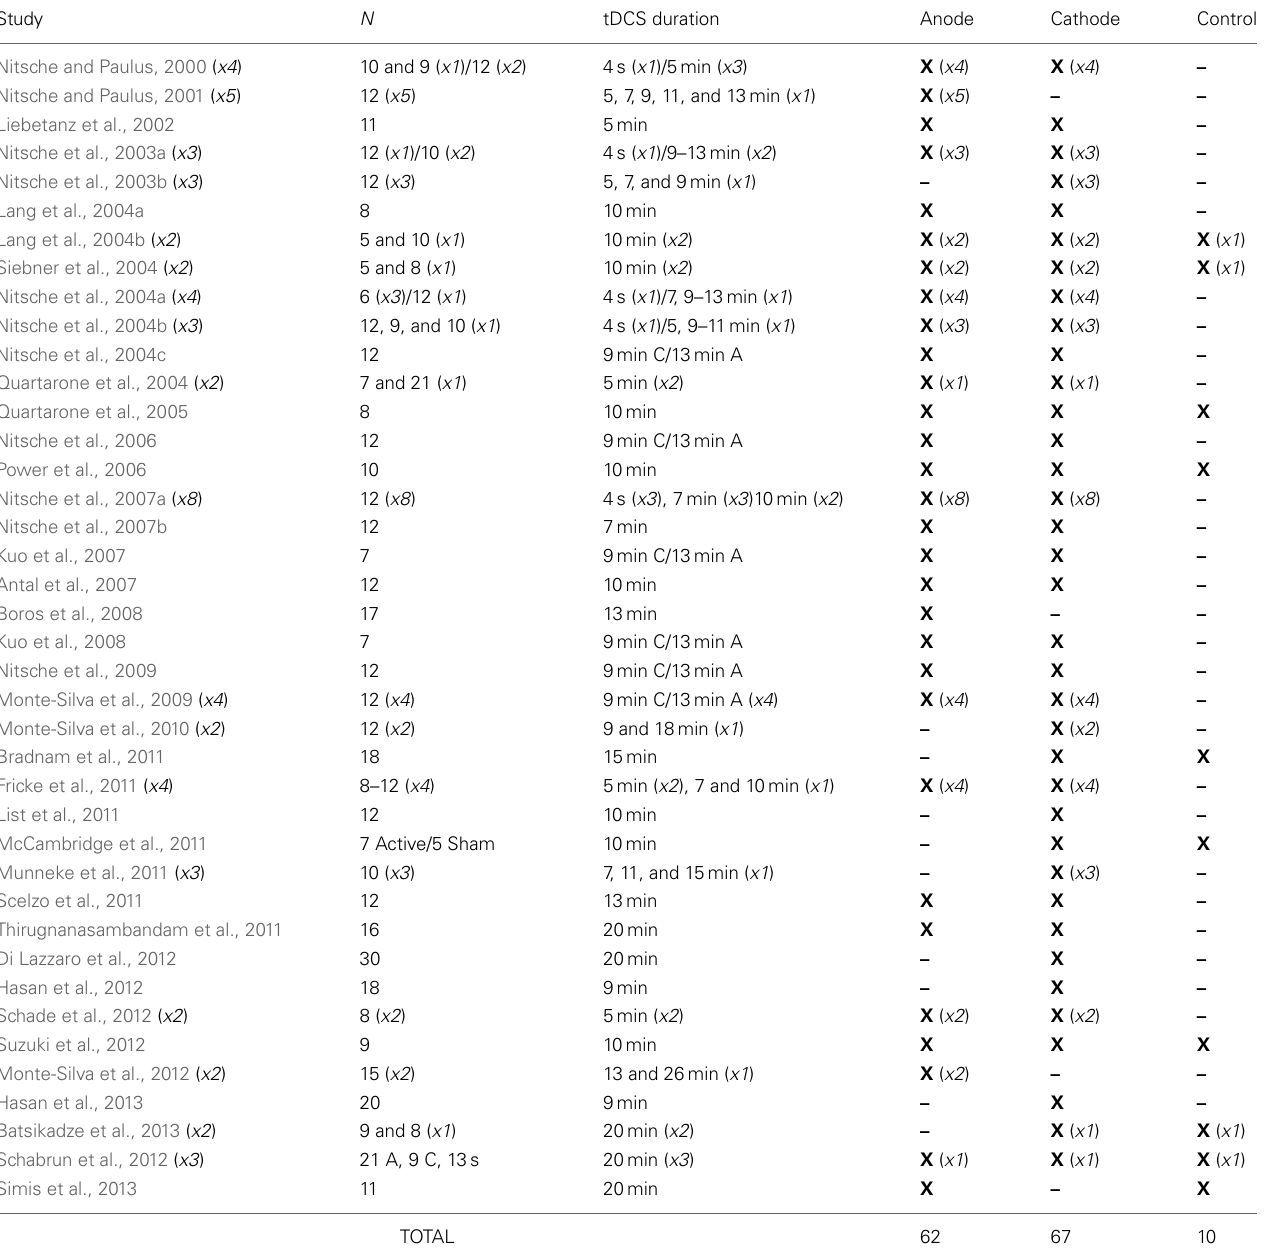
Table 1 | Studies exploring the effects of 0.0286mA/cm 2 current density, M1/Contralateral Orbit tDCS montage on TMS elicited MEP amplitude of intrinsic hand muscles at rest in healthy